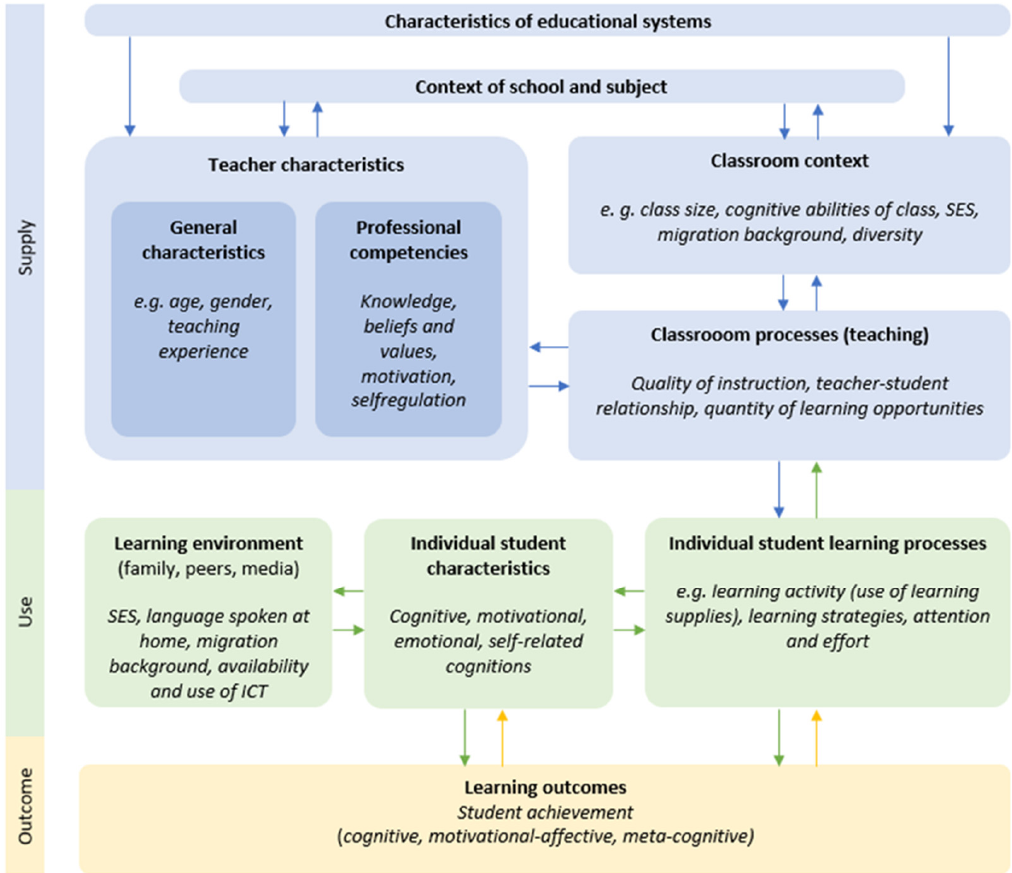
Figure 1. Multilevel supply-use-model adapted from Brühwiler and Blatchford [2] and Seidel [1].